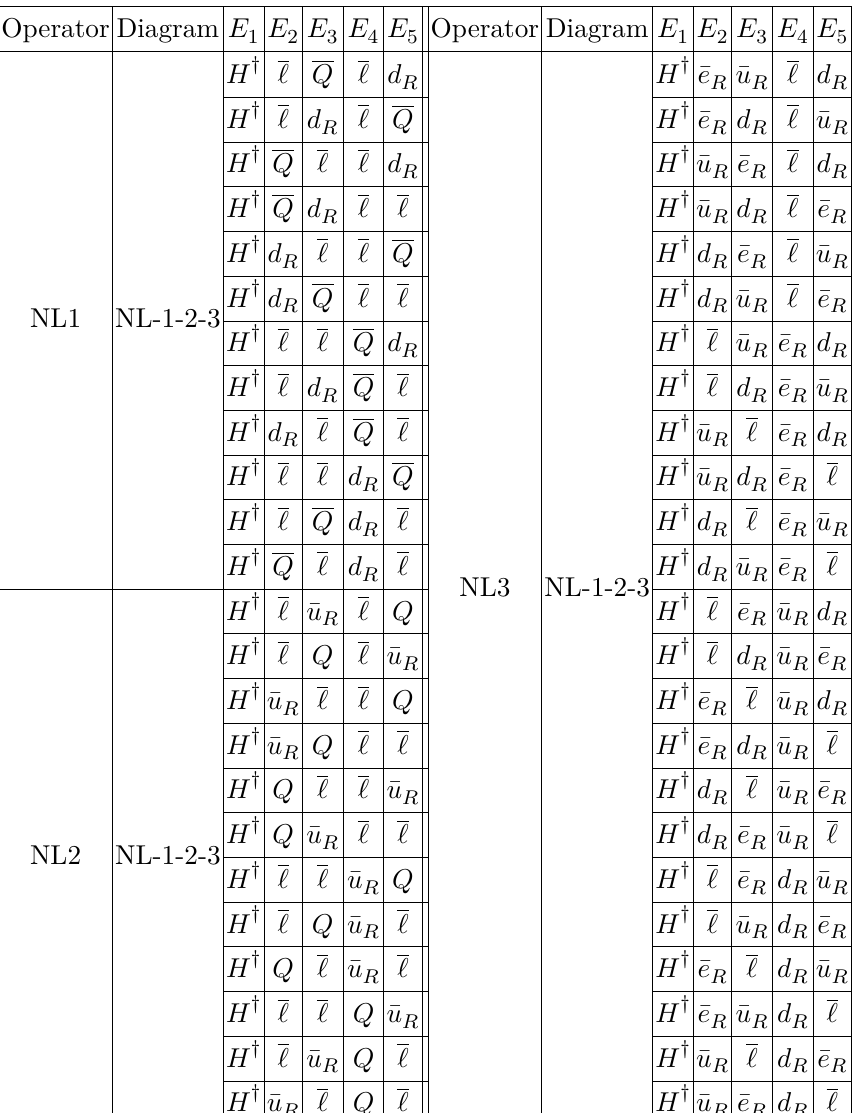
Table 3. The possible external field attachments for the topology NL-1-2, where the external and internal fields are labelled as E